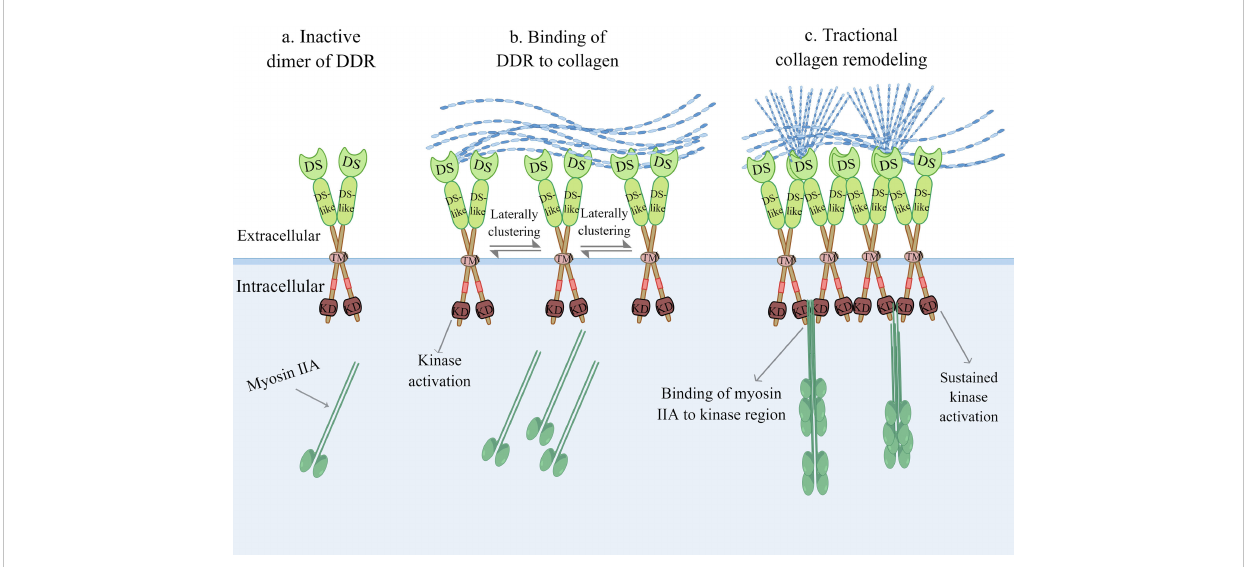
FIGURE 2 Collagen-induced DDR activation. (A) Inactive dimer of DDR without binding to collagen. (B) The activation of DDR and the lateral clusters between DDR proteins are a reciprocal causation. The lateral clusters reinforce the binding of DDR to collagen, meanwhile the increasing lateral clustering of dimers are the result of collagen binding. (C) Upon kinase domain activation, DDR regulates adhesion and traction force on collagen by binding to myosin IIA, which condenses collagen fi brils into more denser alignment. DDR, discoidin domain receptor; DS, discoidin domain; KD, kinase domain; TM, transmembrane domain. (The fi gure is drawn by